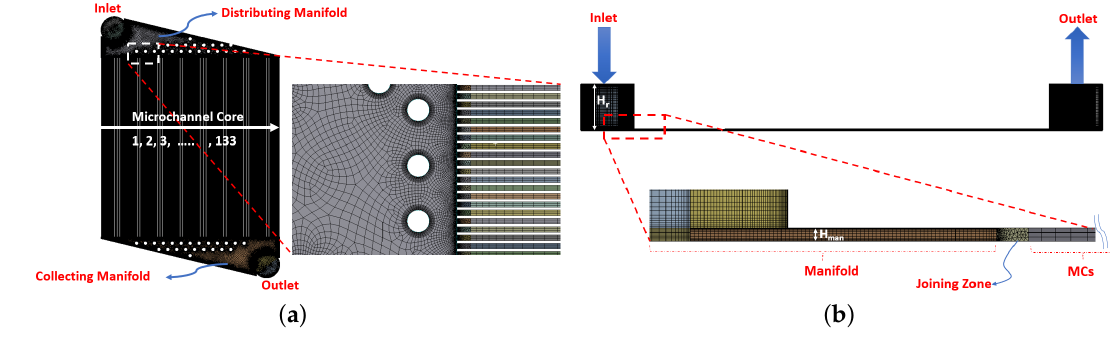
Figure 3. Geometry and mesh details of porous model: top view ( a ), and side view ( b ).